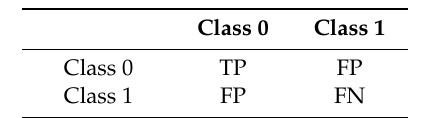
Table 4. Confusion matrix.